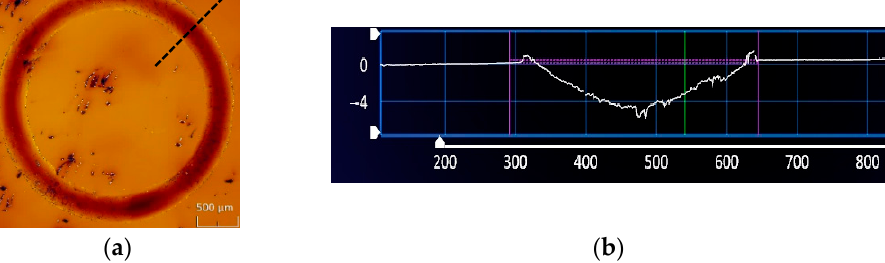
Figure 8. Characterization method of wear loss: ( a ) whole wear track; ( b ) cross-section profile.